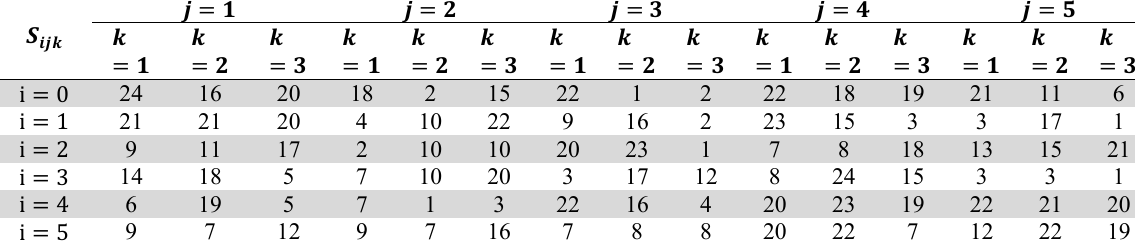
Sequence-dependent setup times for the presented example